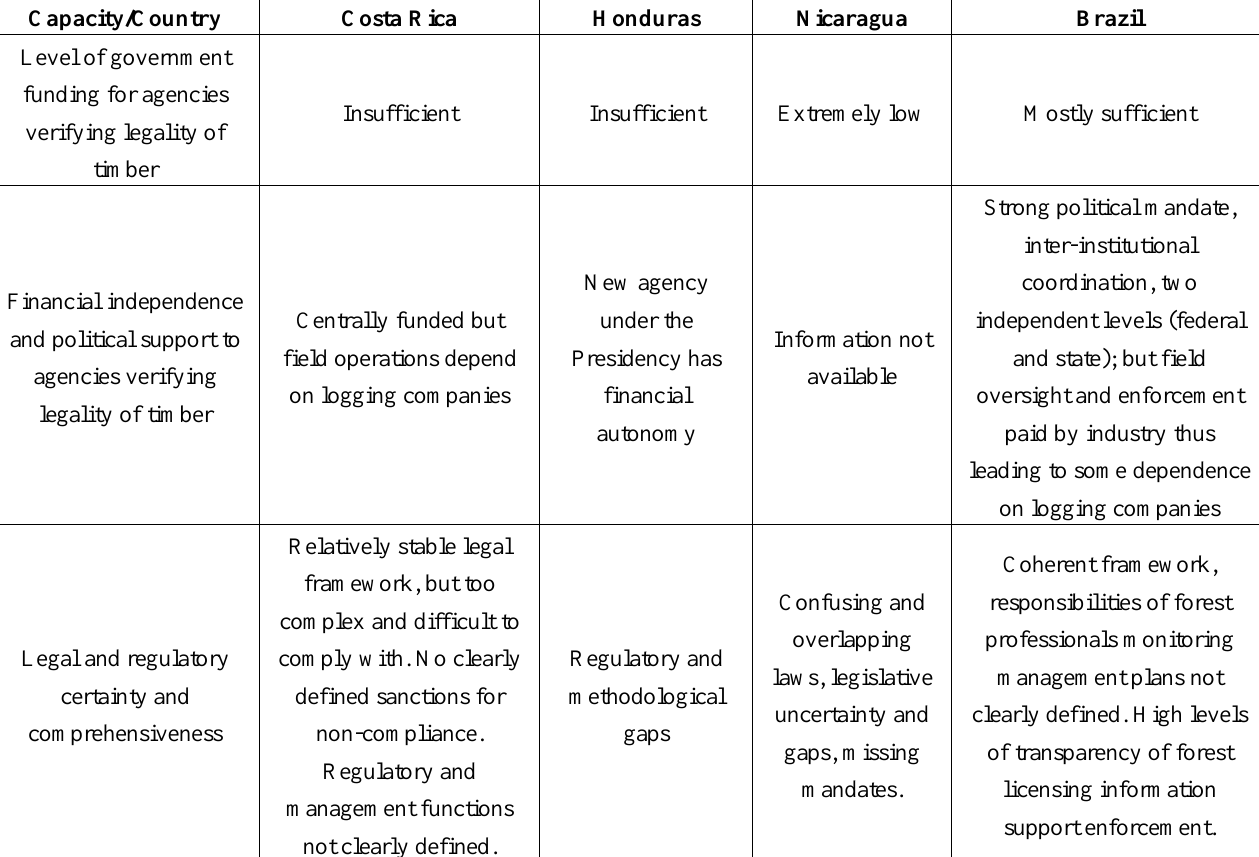
Table 1. Capacity, independence and legal certainty for institutions charged with logging oversight in selected countries in Latin America (Adapted from